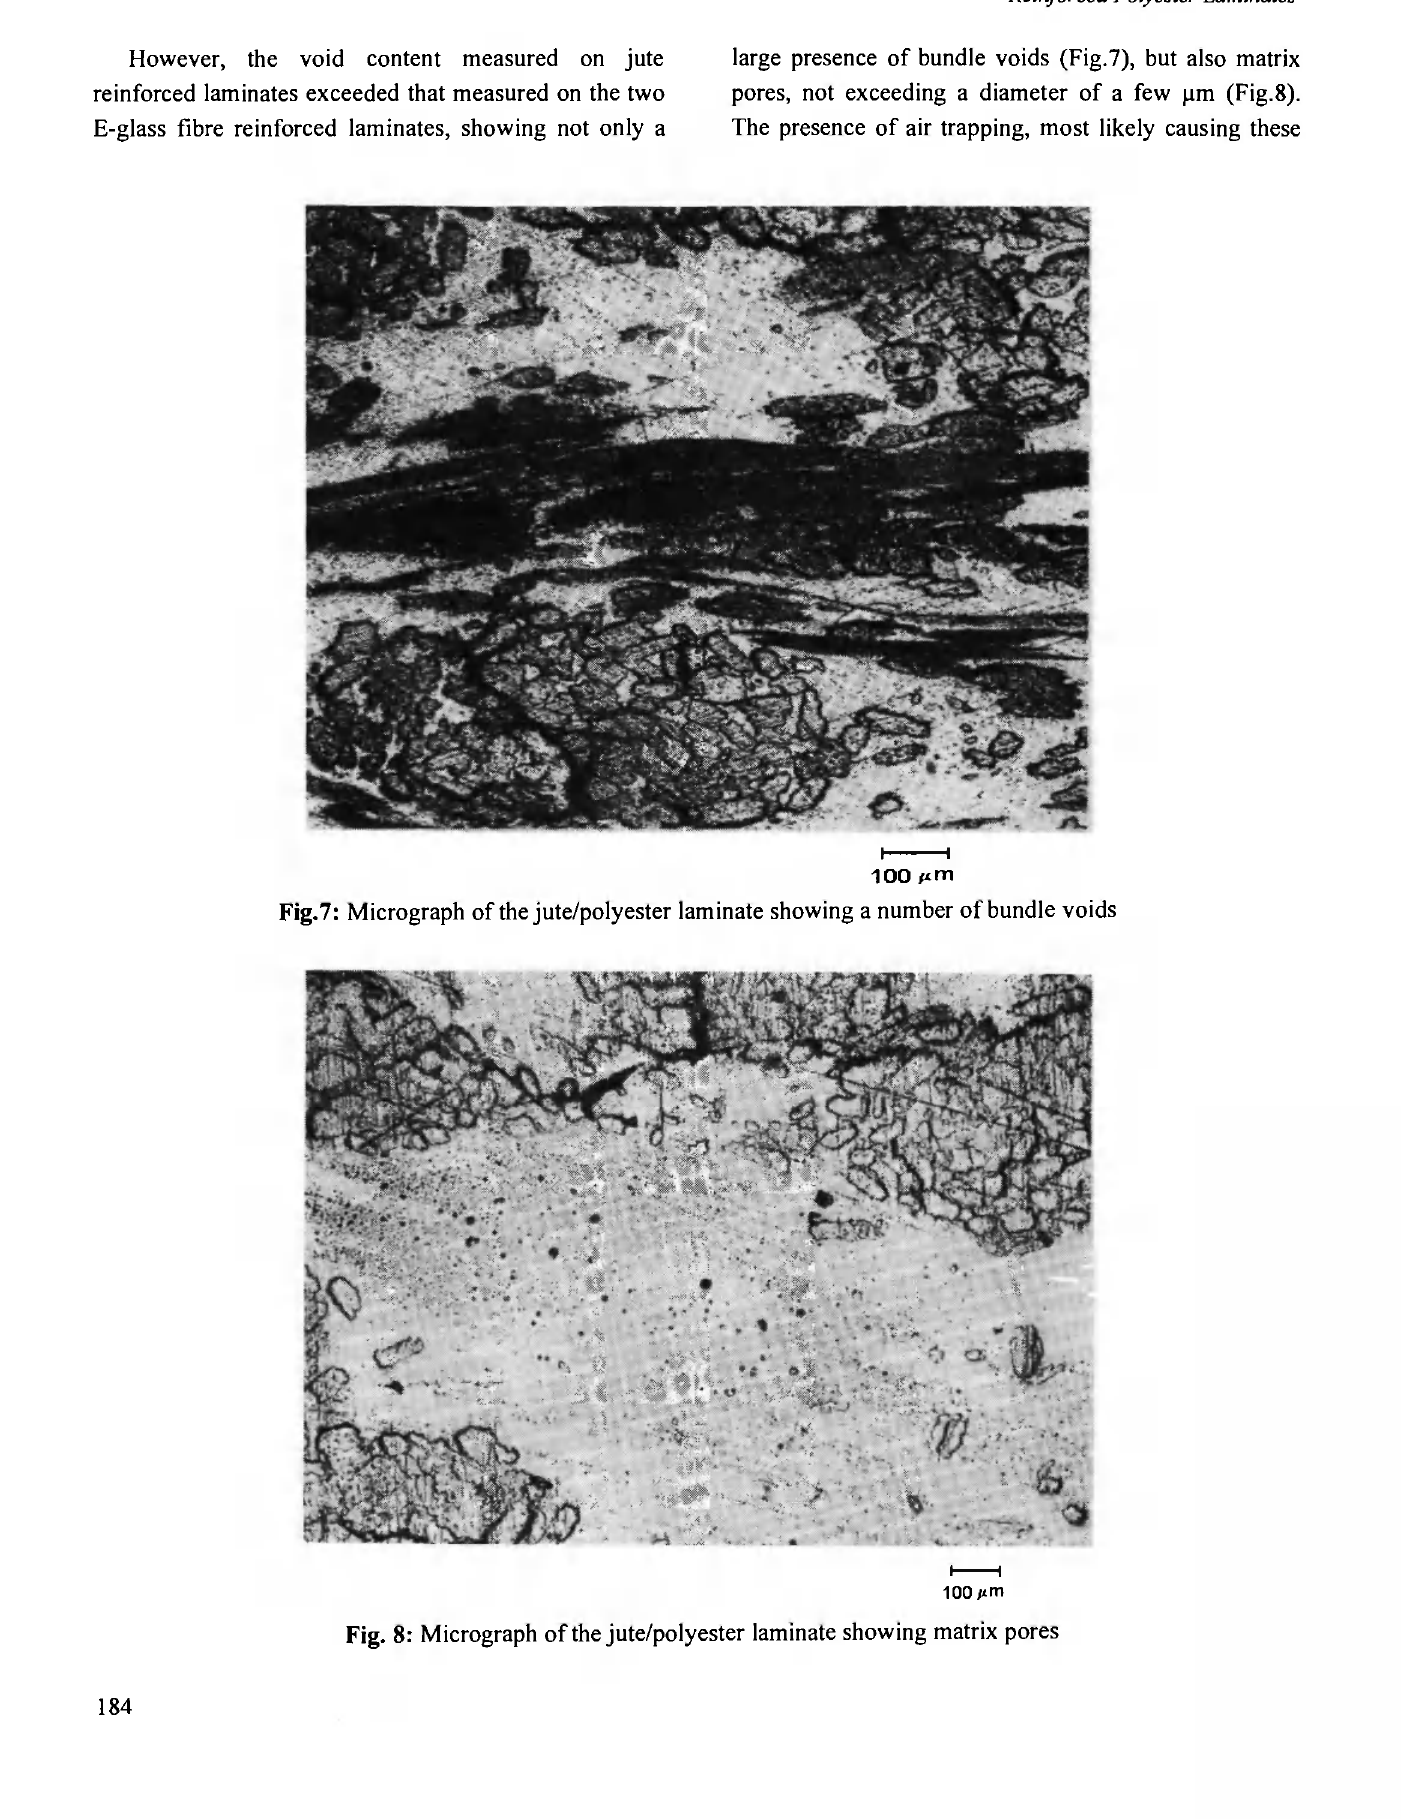
Fig. 8: Micrograph of the jute/polyester laminate showing matrix